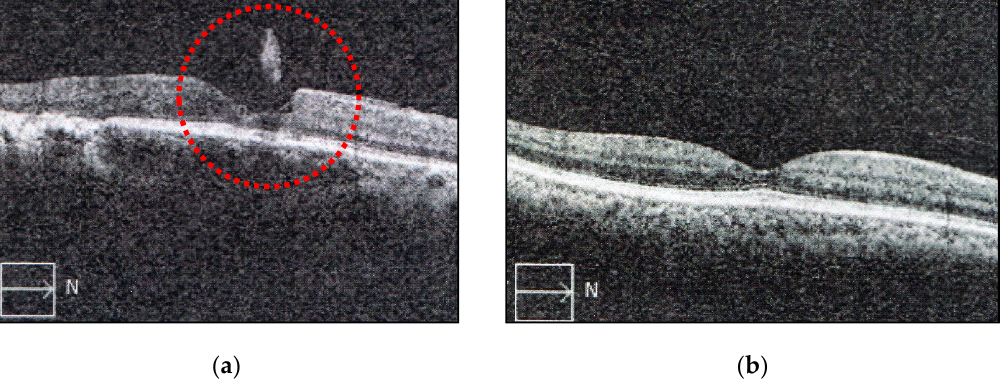
Figure 3. ( a ) Image of vitreous opacity in the posterior vitreous was observed by the optical coherence tomography ( OCT) before treatment; ( b ) symptomatic image of vitreous opacity in the humor vitreous disappeared after taking three fruit enzymes supplement for three months.